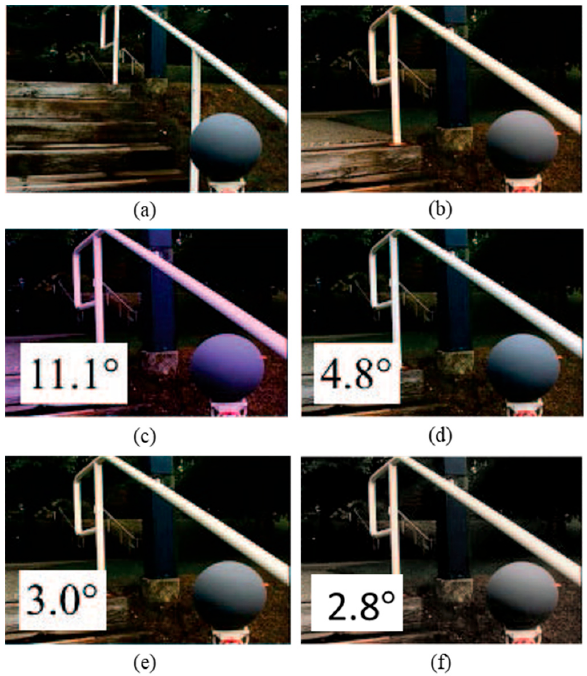
Figure 5. Original, ground truth and its colour-balanced images using different colour correction methods: ( a ) Original image from the Grey Ball dataset [49], ( b ) Ground truth, ( c ) Edge-based-gamut, ( d ) Grey Pixel, ( e ) RCC-Net, ( f ) Proposed CCAFIS’ methods’ images.